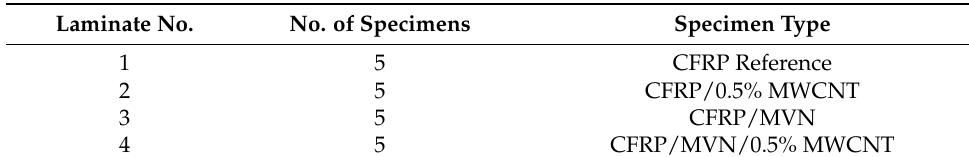
Figure 13. SEM analysis of the tested epoxy/MVN/MWCNT specimens, showing ( a , d ) crack in- terface, ( b , e ) an area from the crack plane and ( c , f ) detailed view of a crack plane for 0.5% and 1% MWCNT, respectively. Table 5. Composite specimens to be tested.